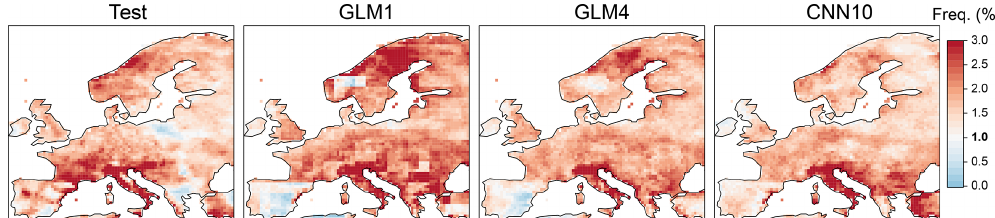
Figure 6. Frequency of exceeding the 99th-percentile value of the training period in each of the grid boxes for the observations in the test period and the test predictions of the GLM1, GLM4 and CNN10 models (in columns). Note that a frequency of 1% (in boldface) would indicate the same amount of values exceeding the (extreme) threshold as in the training